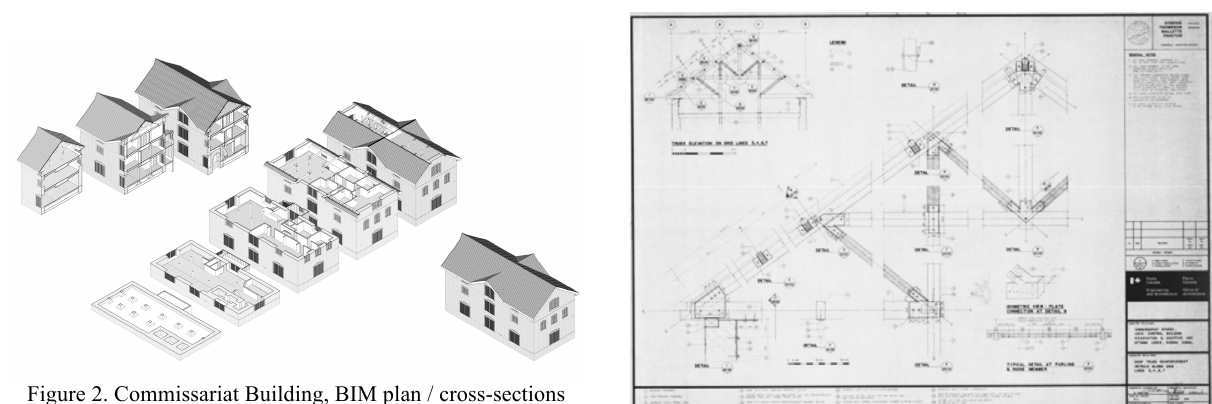
Figure 2. Commissariat Building, BIM plan / cross-sections